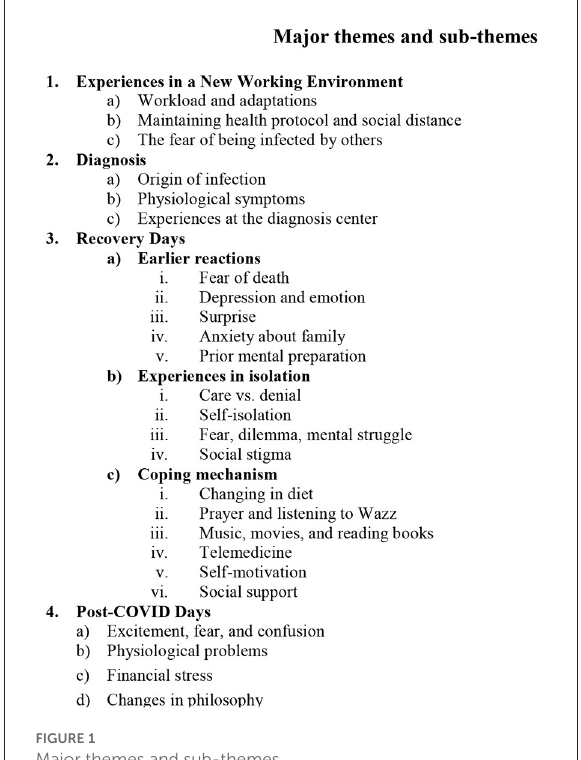
FIGURE1 Major themes and